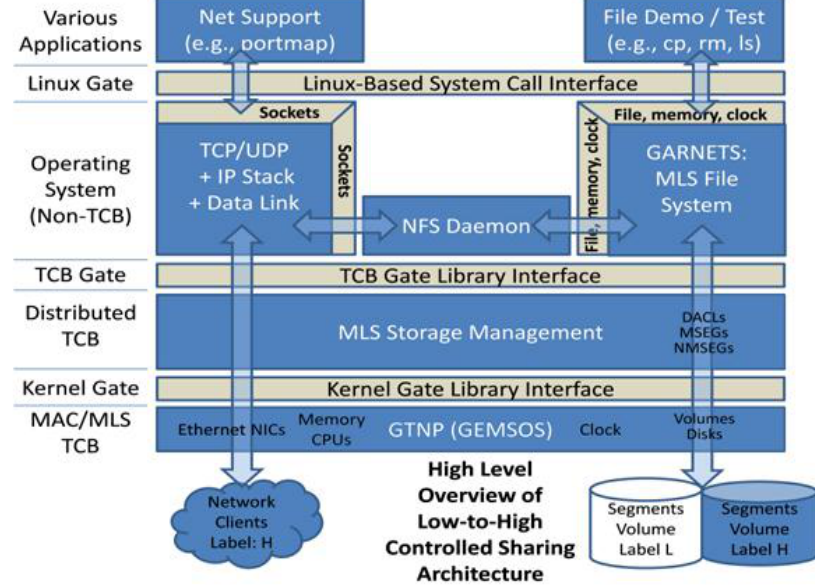
Figure 7. MAC policy-enforcing NFS architecture. GTNP, Gemini Trusted Network Processor; NIC, Network Interface Card.